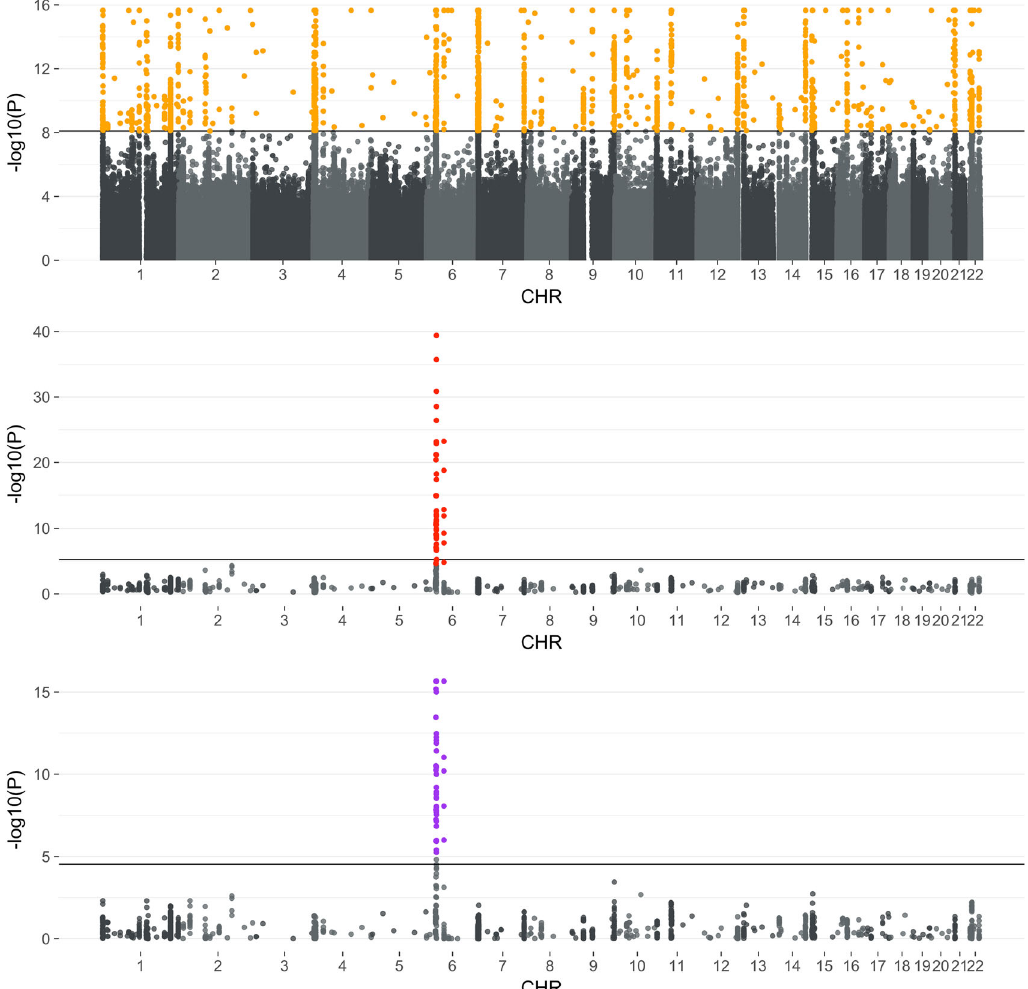
Fig. 5 Manhattan plot of signi fi cant SNPs ’ associations. The top Manhattan plot shows the association results of Sum-Share in eMERGE. Each p -value displayed ( y -axis) is obtained from the test between an SNP ( x -axis) and fi ve phenotypes. The straight crossing line indicates the Bonferroni adjusted p -value threshold of 8.19 × 10 − 9 . The middle Manhattan plot displays the signi fi cant SNPs identi fi ed in Sum-Share (orange dots in the top panel) analyzed using PheWAS in the UK BioBank data. Each p -value displayed ( y -axis) is the minimum p -values between an SNP ( x -axis) and fi ve phenotypes. The straight-line indicates the Bonferroni adjusted p -value threshold of 0.05/(1698*5) = 5.89 × 10 − 6 . The bottom Manhattan plot shows the same SNPs analyzed by Sum-Share in the UK BioBank data. The Bonferroni adjusted p -value threshold is 0.05/1698 = 2.94 × 10 − 5